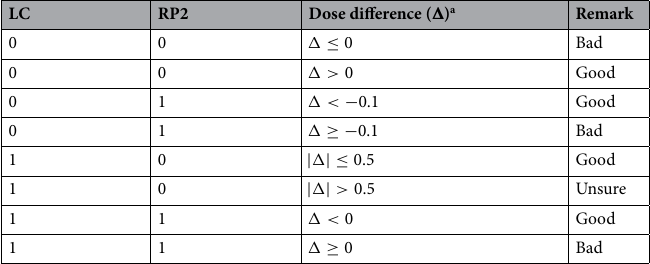
Table 1. Self-evaluation scheme. Evaluation scheme for AI recommendation based on the radiation dose to outcome relationship—the probability of both LC and RP2 increases with increase in radiation dose. Here LC and RP2 are retrospective treatment outcome and LC = 1 and RP2 = 0 are the clinically desired outcome. For a patient with known treatment outcome, we can evaluate an AI recommendation by comparing it with the retrospective clinical dose decision. For instance, for a patient with LC = 0 and RP2 = 0, we can say that the patient should have been given a higher dose. a (cid:31) = AI recommendation – Clinical decision. 0: no event, 1: event. LC local control, RP2 radiation-induced pneumonitis of grade 2 or